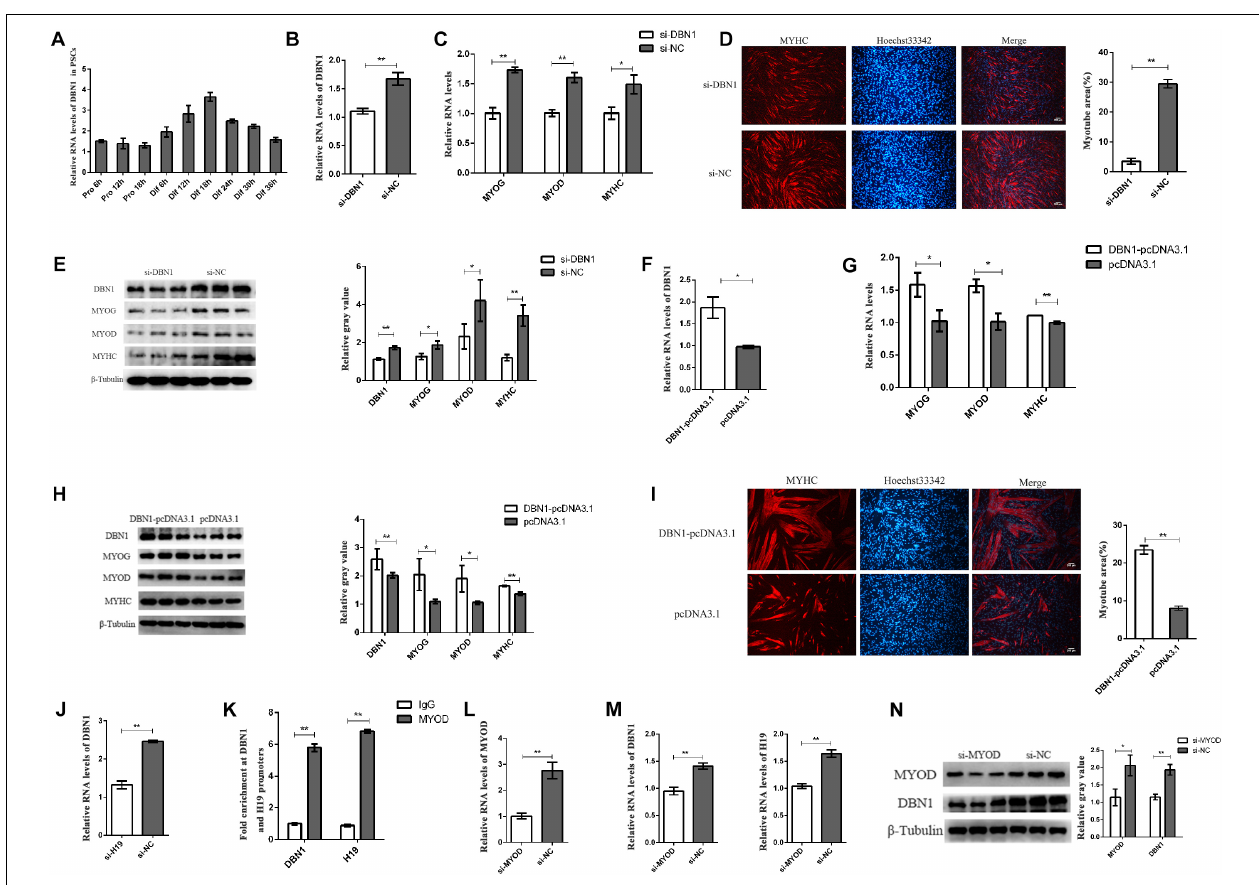
FIGURE 7 | DBN1 affects the PSC differentiation. (A) Real-time PCR analysis of DBN1 expression in PSCs during the period of proliferation and differentiation. There is a 6-h interval between each period. SNRNP70 was used as positive control in RIP. Mean values ± SEM, n = 3. The values are shown as means ± SD of three independent experiments. (B–E) Knockdown of DBN1 inhibited the expression of MYOG, MYOD, and MYHC. (F–I) Overexpression of DBN1 promoted the expression of MYOG, MYOD, and MYHC. (J) Real-time PCR analysis of expression of DBN1 in PSCs after transfection with H19 siRNA. (K) ChIP-qPCR results revealed the enrichments of MYOD at the H19 and DBN1 promoters. (L,M) Knockdown of MYOD inhibited the expression of DBN1 and H19. (N) Knockdown of MYOD inhibited the protein level of DBN1. Mean values ± SEM, n = 3. The values are shown as means ± SD of three independent experiments. * P < 0.05, ** P <